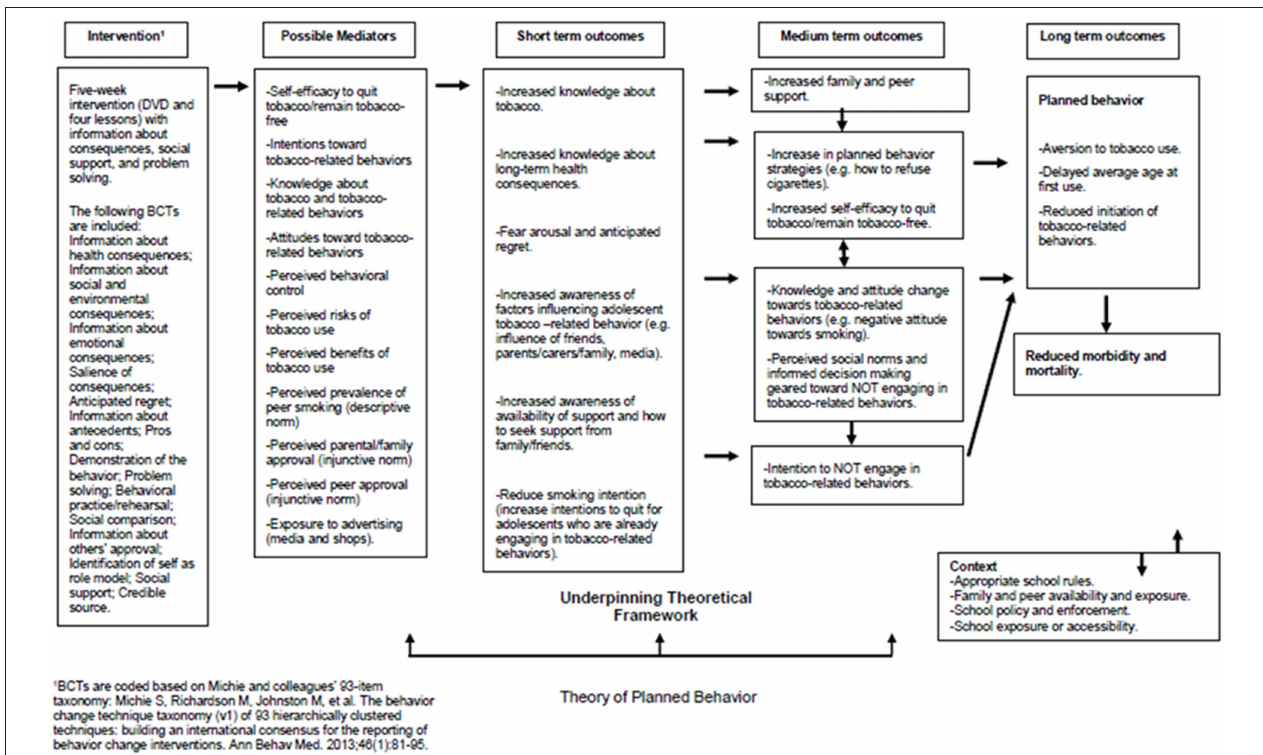
FIGURE 2 | Proposed logic model for Dead Cool